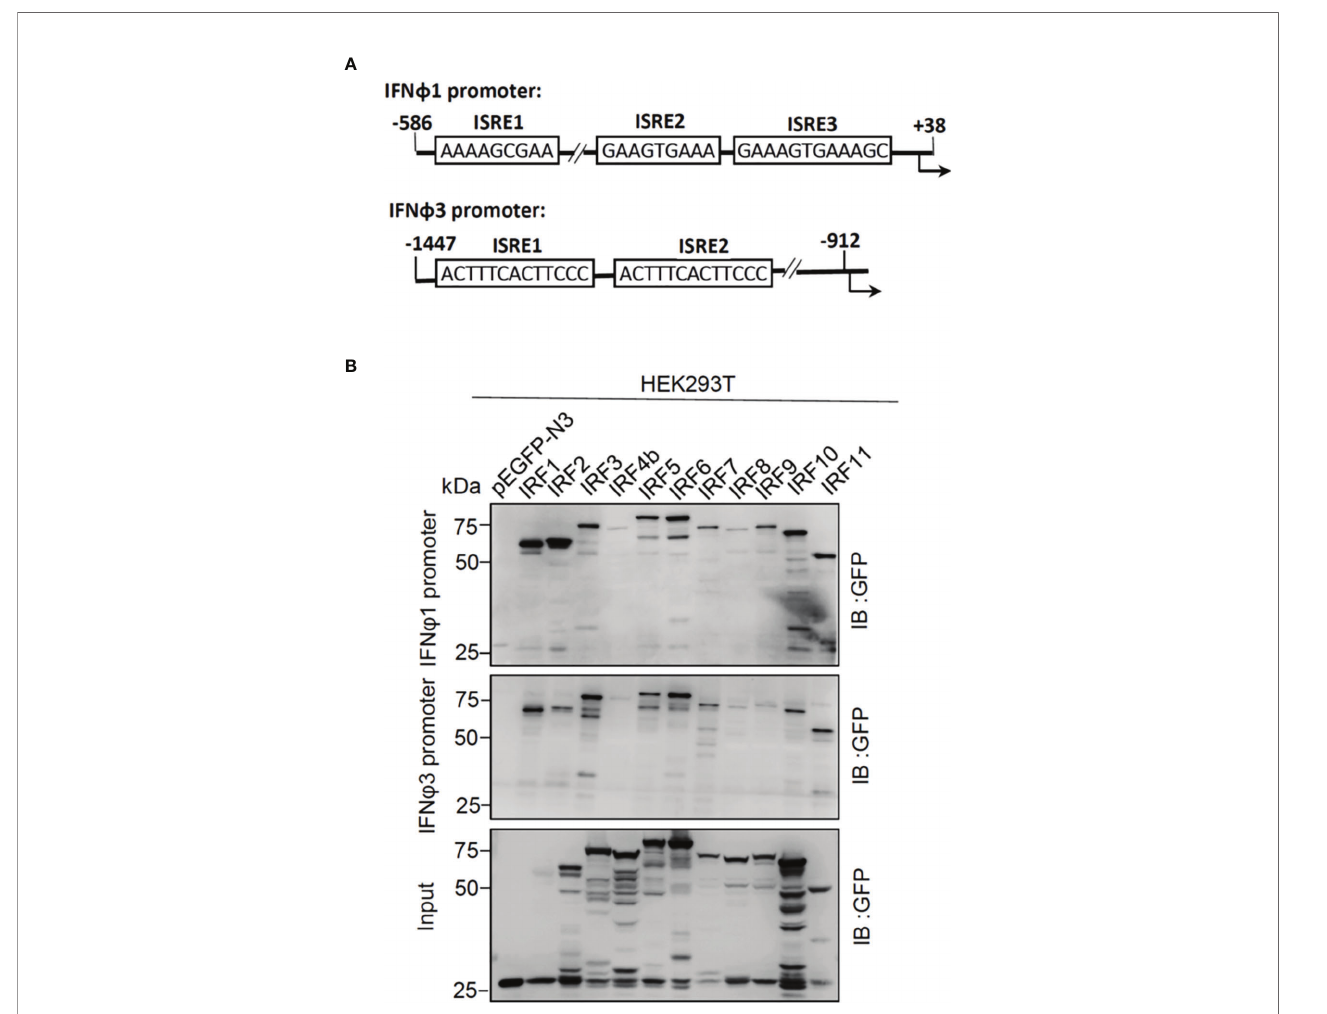
FIGURE 3 | Zebra fi sh IRF proteins bind to zebra fi sh promoter DNA. (A) Schematic diagram of zebra fi sh IFN j 1 and IFN j 3 promoters, showing the position and sequence of potential ISRE/IRF-E motifs. (B) The binding of zebra fi sh IRF proteins to zebra fi sh IFN promoter DNA. The biotin-labeled DrIFN j 1 (-586 to +38) or DrIFN j 3 (-1447 to -910) promoter DNA (20 ng each) was incubated with the excessive amounts of zebra fi sh IRF proteins, or with GFP as control. Zebra fi sh IRF and GFP proteins were derived from the lysates of HEK293T cells that had been transfected for 30h with plasmids expressing zebra fi sh IRF protein fused to GFP or pEGFP-N3, respectively. One-tenth of cell lysates were taken as input. The bead-bound DNA-protein complex was detected by the Ab speci fi c to the GFP tag using